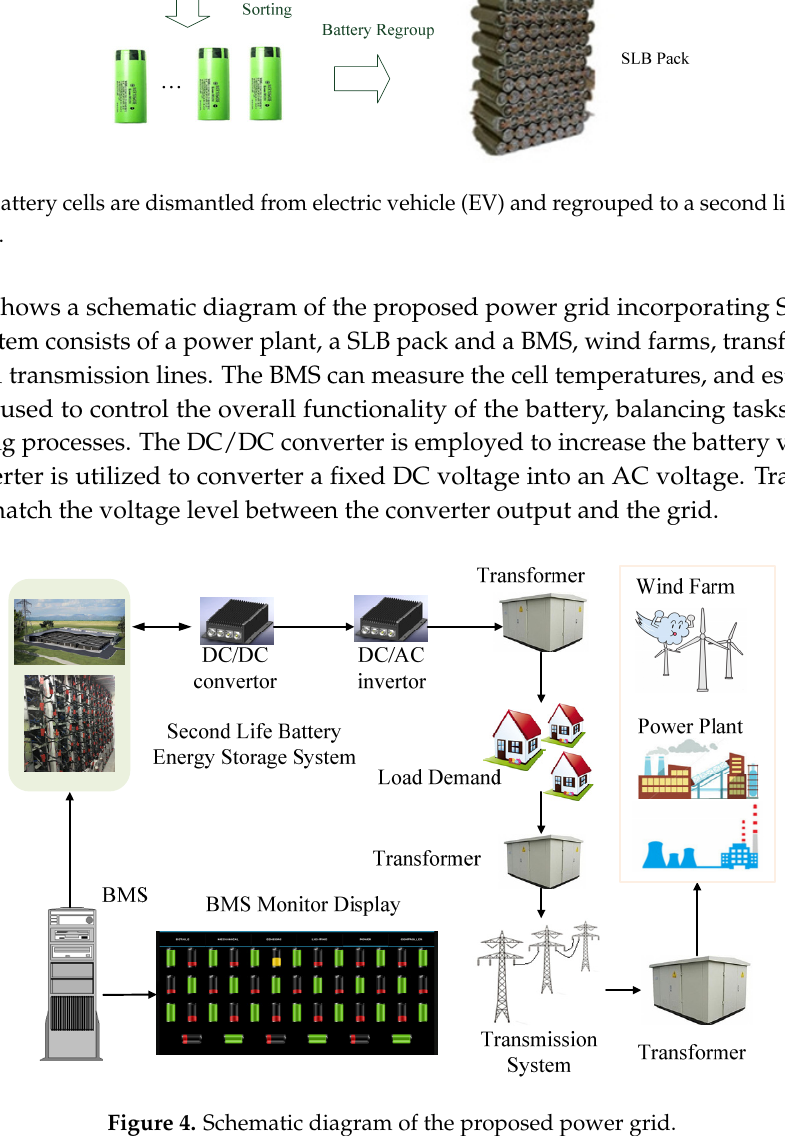
Figure 4. Schematic diagram of the proposed power grid.